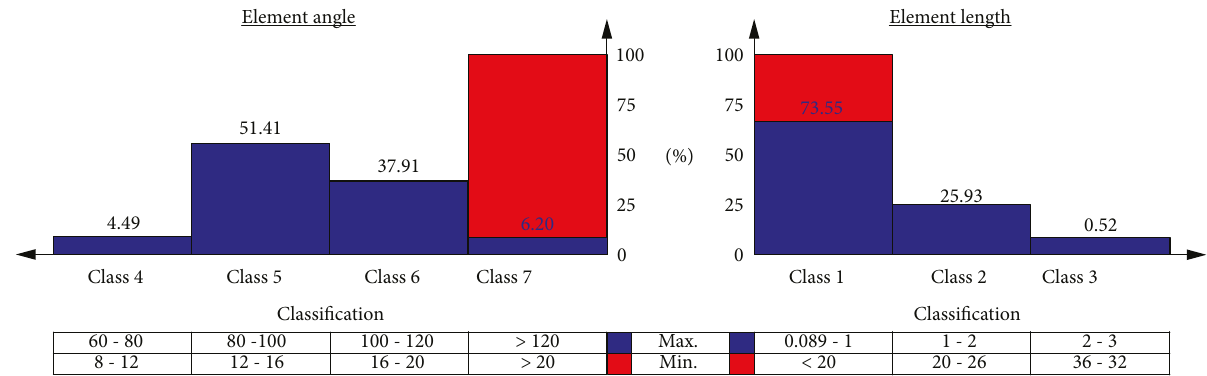
Figure 3: Mesh-related quality e ff ectiveness of the di ff erent gel pads ’ positioning and shape.